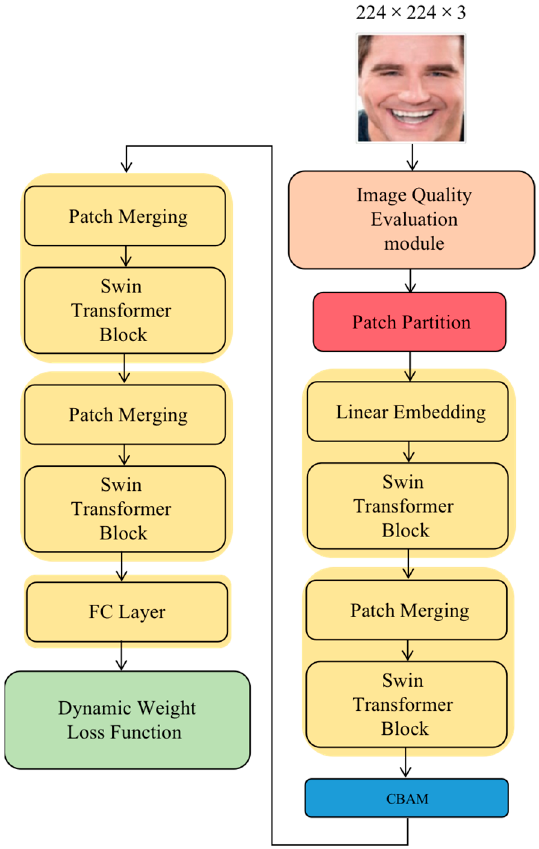
Figure 5. Illustration of the proposed Smile Transformer.